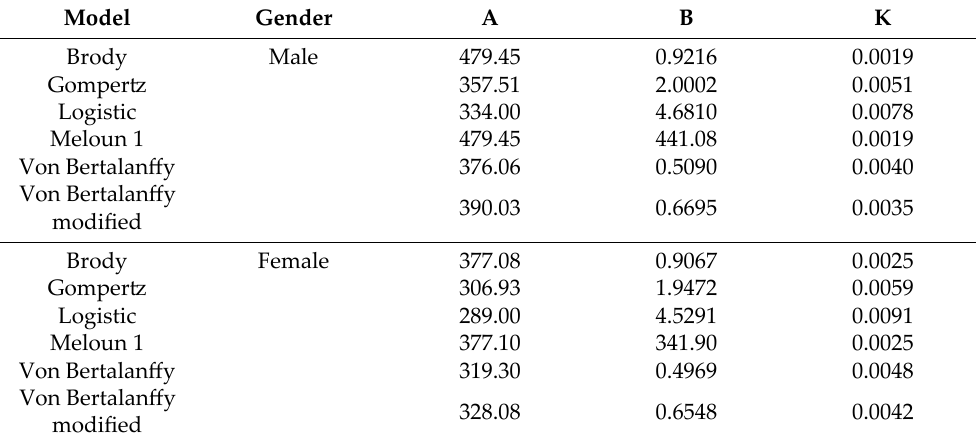
Table 3. Estimates of asymptotic weight (A), in kg, constant of integration (B) and rate of maturation (K), in days, for all nonlinear functions and in each